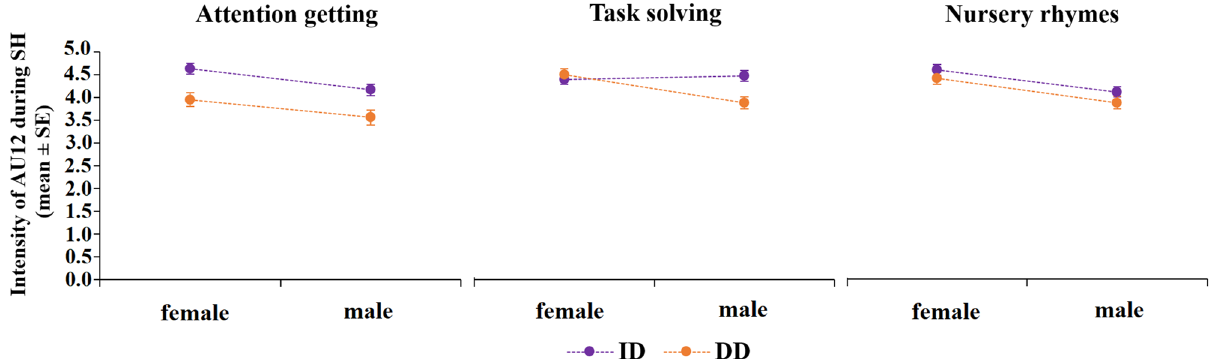
Figure 3. Mean (+ SE) scores of intensity of the lip corner puller (AU12) of male and female speaker’s Special Happy (SH) face in the three experimental situations. DD dog-directed, ID infant-directed